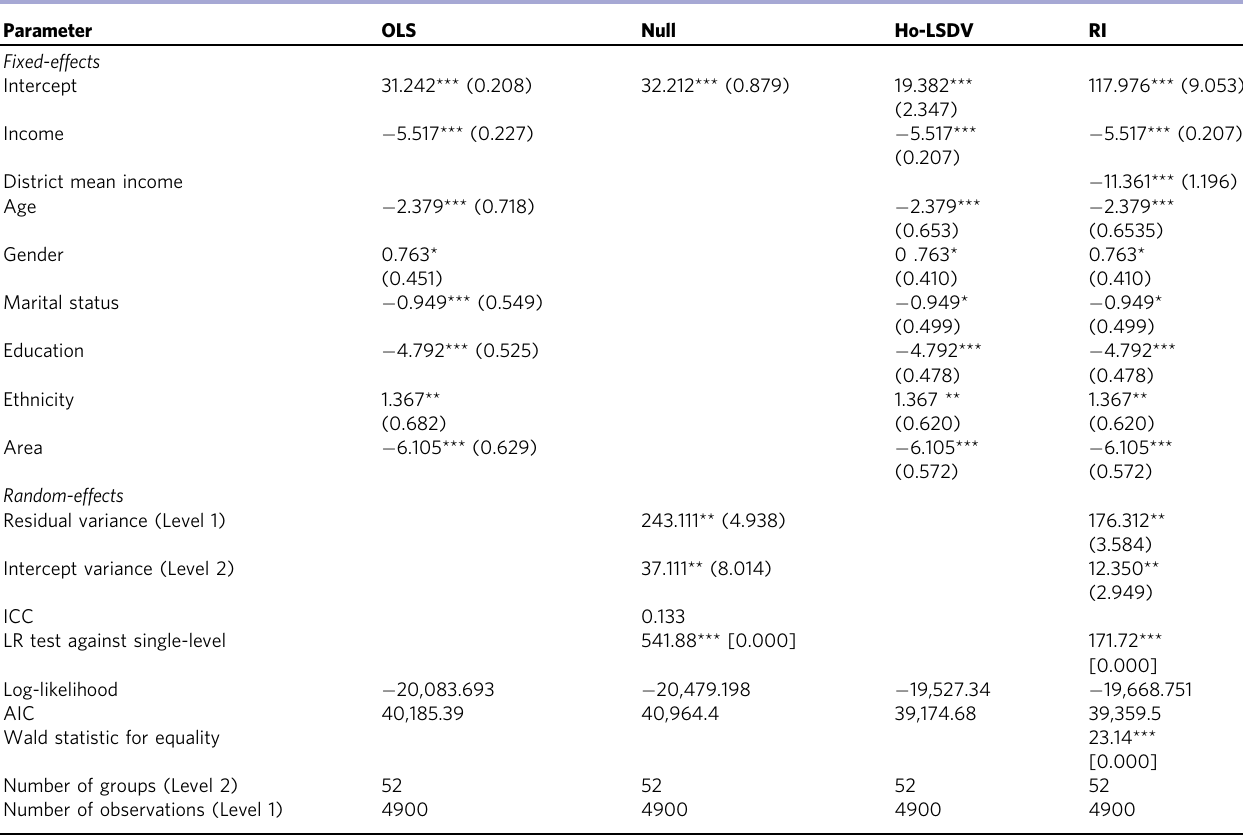
Table 4 Results of homogeneous